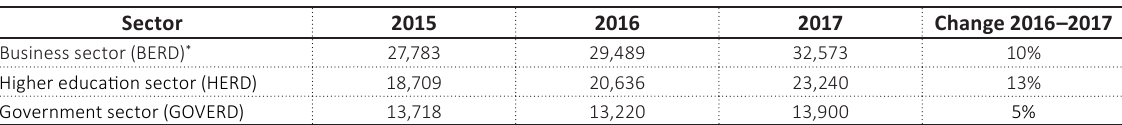
Table 2. R&D expenditure by performing sector and a total number of R&D man-years in 2015, 2016, and 2017, mill. kroner and percentage change (current prices)